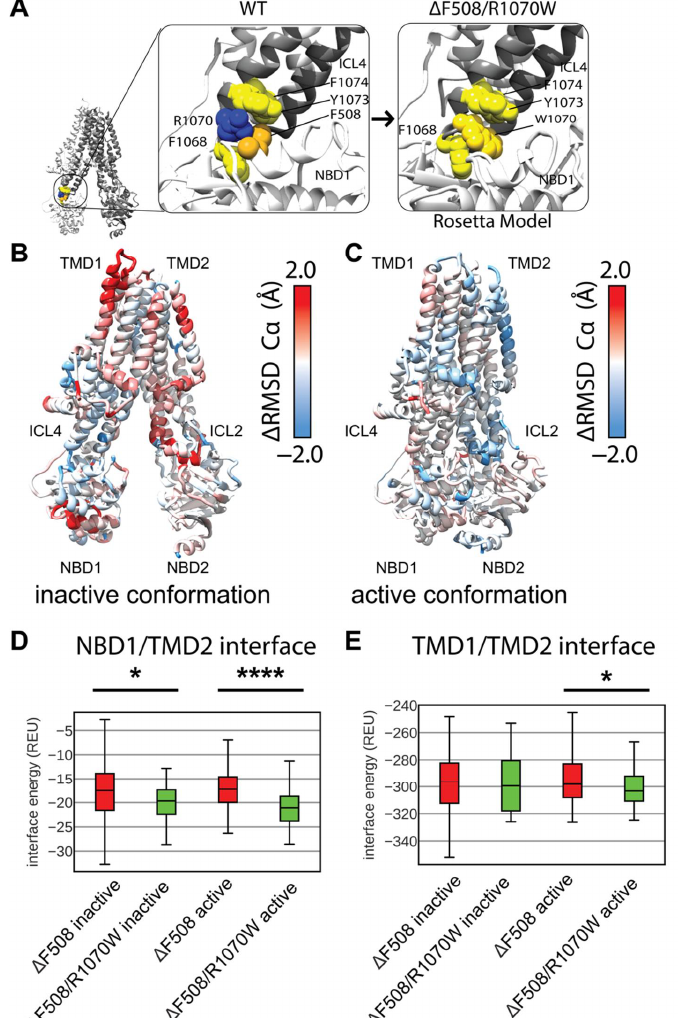
Figure 5. R1070W stabilizes the NBD1/TMD2 interface. ( A ) F508 in 5UAK CFTR (gold spheres) contacts an aromatic pocket in ICL4 formed by F1068, Y1073, and F1074 (yellow spheres). This aromatic pocket is filled with R1070 (blue) is mutated to a tryptophan (left). ( B ) Average residue C α RMSD of the lowest scoring 100 inactive state F508del /R1070W models subtracted from the C α RMSD of the lowest scoring 100 inactive state F508del models mapped on 5UAK. Here, red represents region where the RMSD was higher in F508del/R1070W than F508del alone, and blue represents regions where the RMSD was lower and hence stabilized by R1070W. ( C ) Average residue C α RMSD of the lowest scoring 100 inactive state F508del /R1070W models subtracted from the C α RMSD of the lowest scoring 100 inactive state F508del models mapped on 6MSM. ( D ) Quantification of the residue-residue interactions at the NBD1/TMD2 interface across the lowest scoring 100 models. The box limits represent the upper and lower quartile with a line at the median, the whiskers represent 1.5 times the interquartile range, statistical significance was calculated with a Mann–Whitney U test and p -values are depicted by * < 0.05, and **** < 0.0001. ( E ) Quantification of the residue-residue interactions at the TMD1/TMD2 interface across the lowest scoring 100 models. R1070W likely stabilize TMD2 enough to reduce the interaction energy between the TMDs in the active